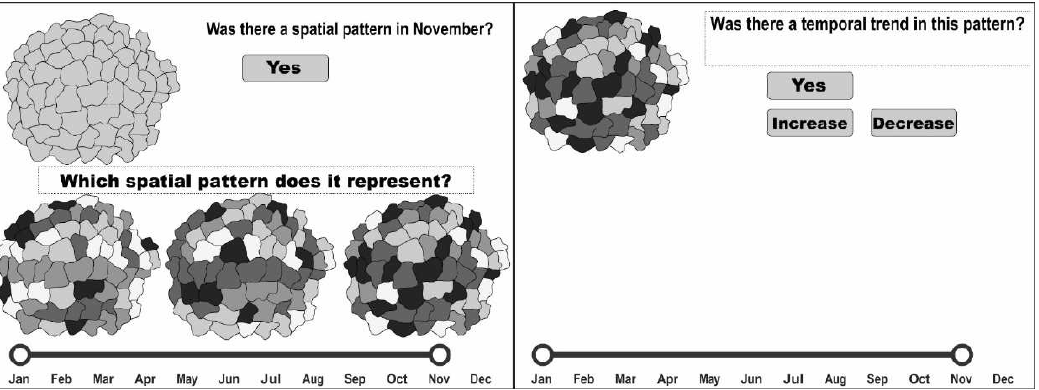
Figure 2. Selected frames of a linear and dispersed pattern. An increasing trend is in a linear pattern. The dispersed pattern has no trend. In D4, the spatial pattern is only visible at both ends of animation and did not appear in other months. Li—linear increasing, D4—dispersed pattern map number 4.